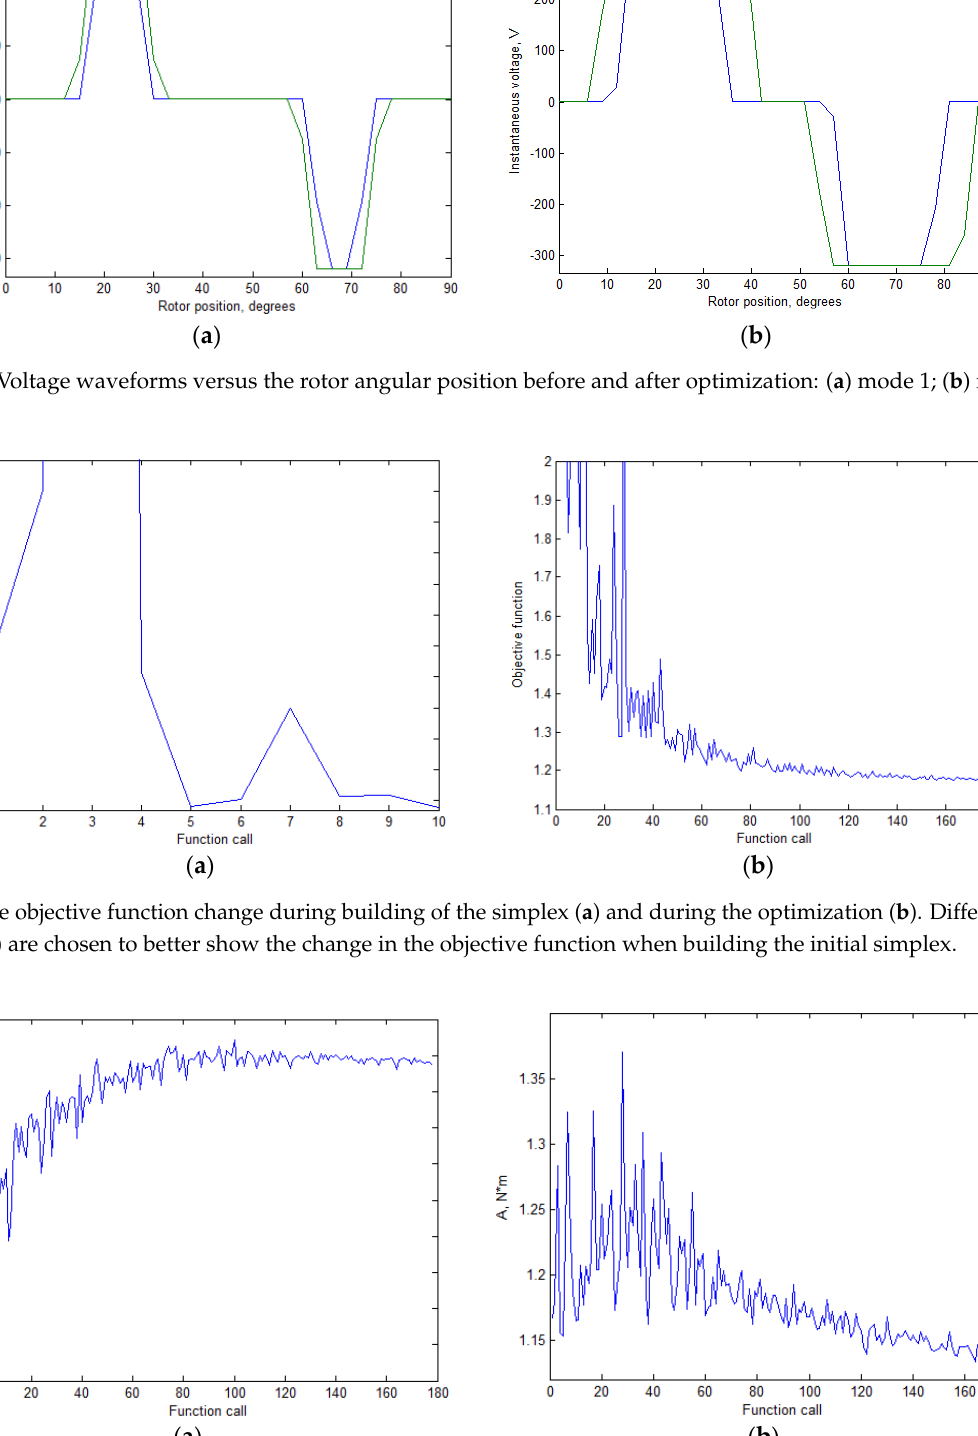
Figure 7. ( a ) Variation of the average efficiency during the optimization; ( b ) variation of the torque oscillations during the